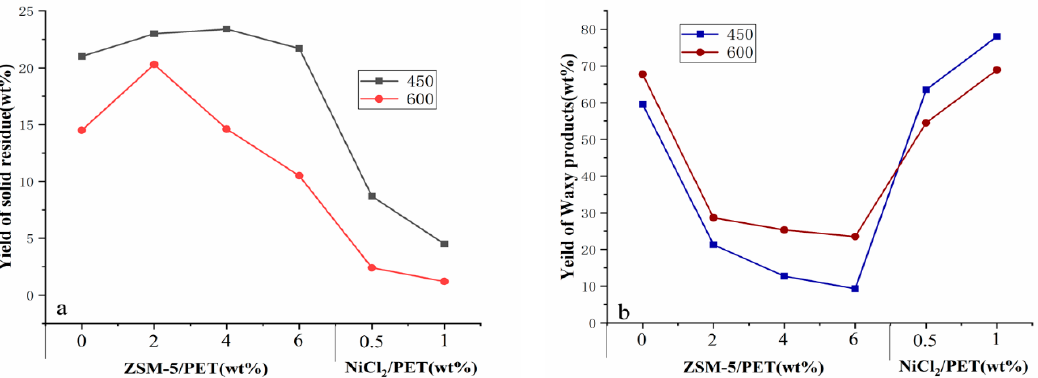
Figure 4. Effect of temperature and catalyst: PET mass ratio on the yield of solid residue ( a ) and waxy products ( b ).